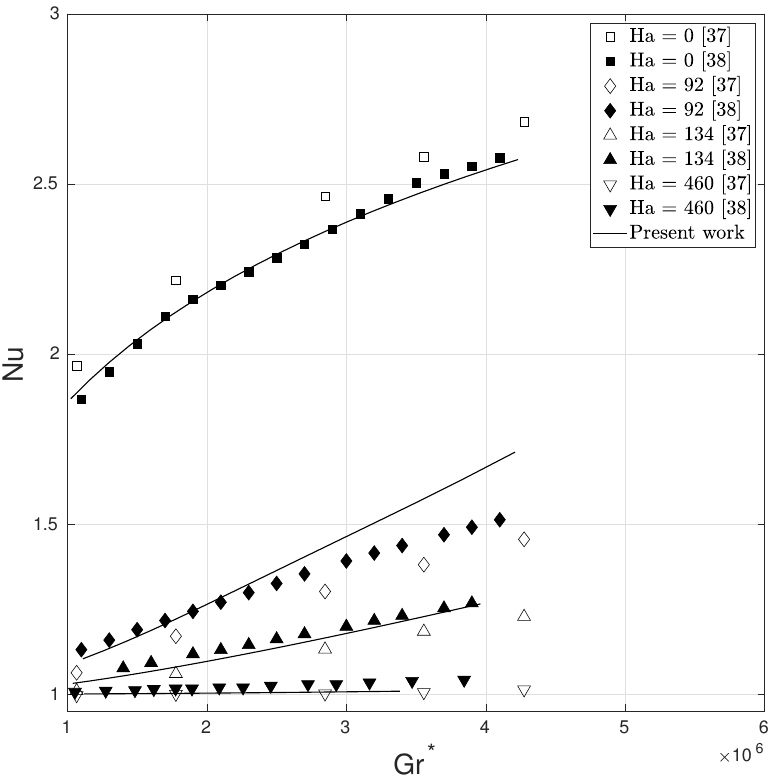
Figure 11. Comparison of the numerical results with the experimental results of Okada et al. [37] and computational results of Meng et al. [38] for Nusselt number variation with Gr ∗ at different Ha for the 3D natural convection